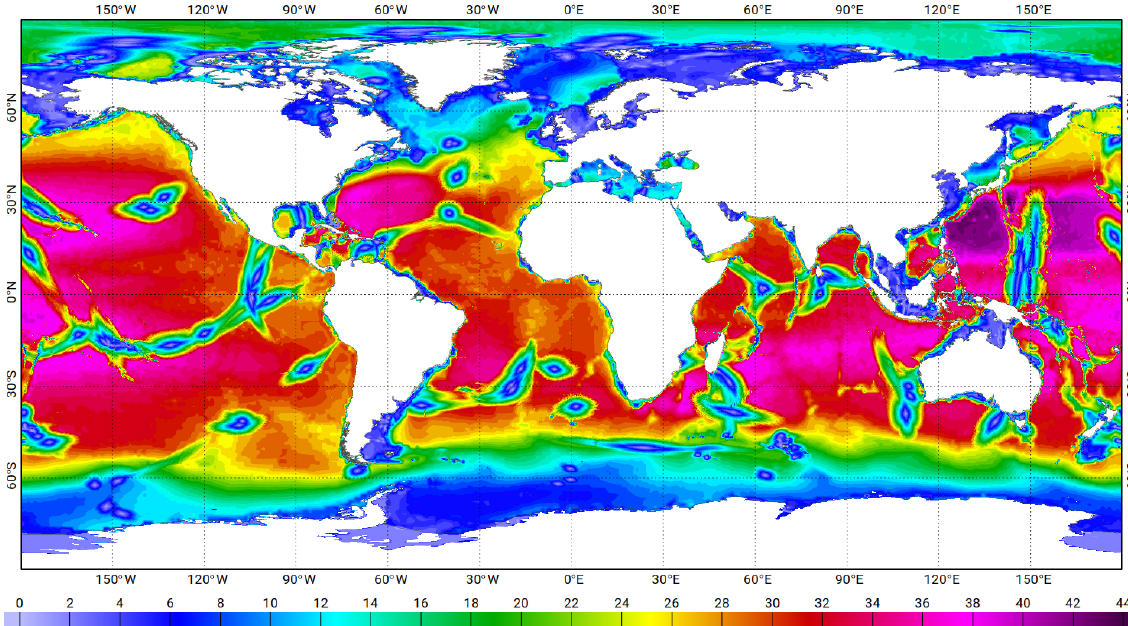
Figure 5. Along-track filtering wavelength used to remove internal tides’ surface signatures (expressed in number of 1Hz along-track points, to be multiplied by a factor of 6 to retrieve the equivalent wavelength in